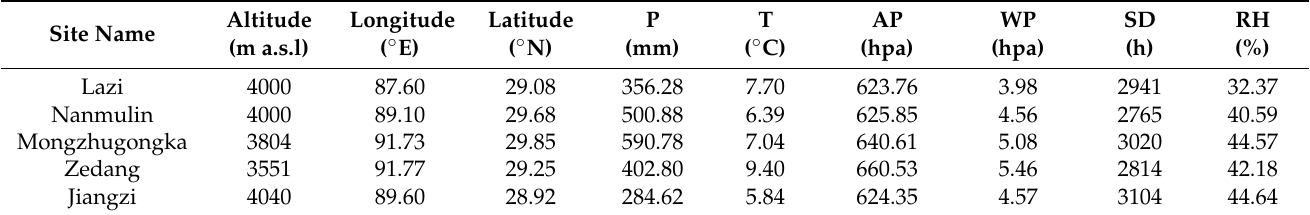
Figure 1. Location of the study area and the distribution of meteorological stations and cropland of highland barley. The land use data of Tibet in 2015 were collected from the Resource and Environment Science and Data Center, Chinese Academy of Sciences (https://www.resdc.cn, accessed on 27 July 2021). These data were interpreted from the Landsat images, with 30 m resolution. Meteorological data, including sunshine duration (SD), air temperature (T), precipitation (P), and air pressure (AP), water vapor (WP), and relative humidity (RH) were obtained from the China Meteorological Data Service Center at 5 meteorological stations during the same period with ET product. The distribution of meteorological stations is shown in Figure 1, and detailed information on these stations is listed in Table 1. Table 1. Detailed information on meteorological stations.